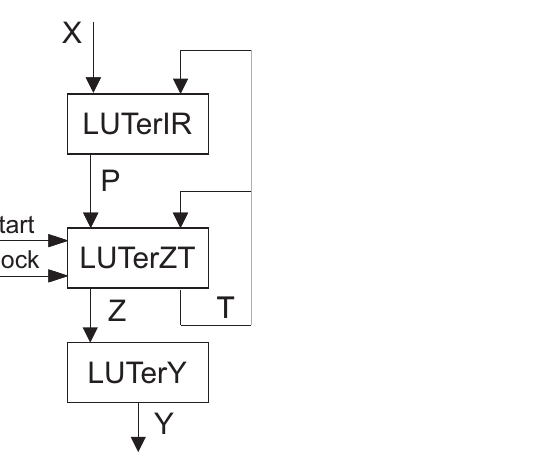
Figure 4. Structural diagram of LUT-based MPY Mealy FSM.